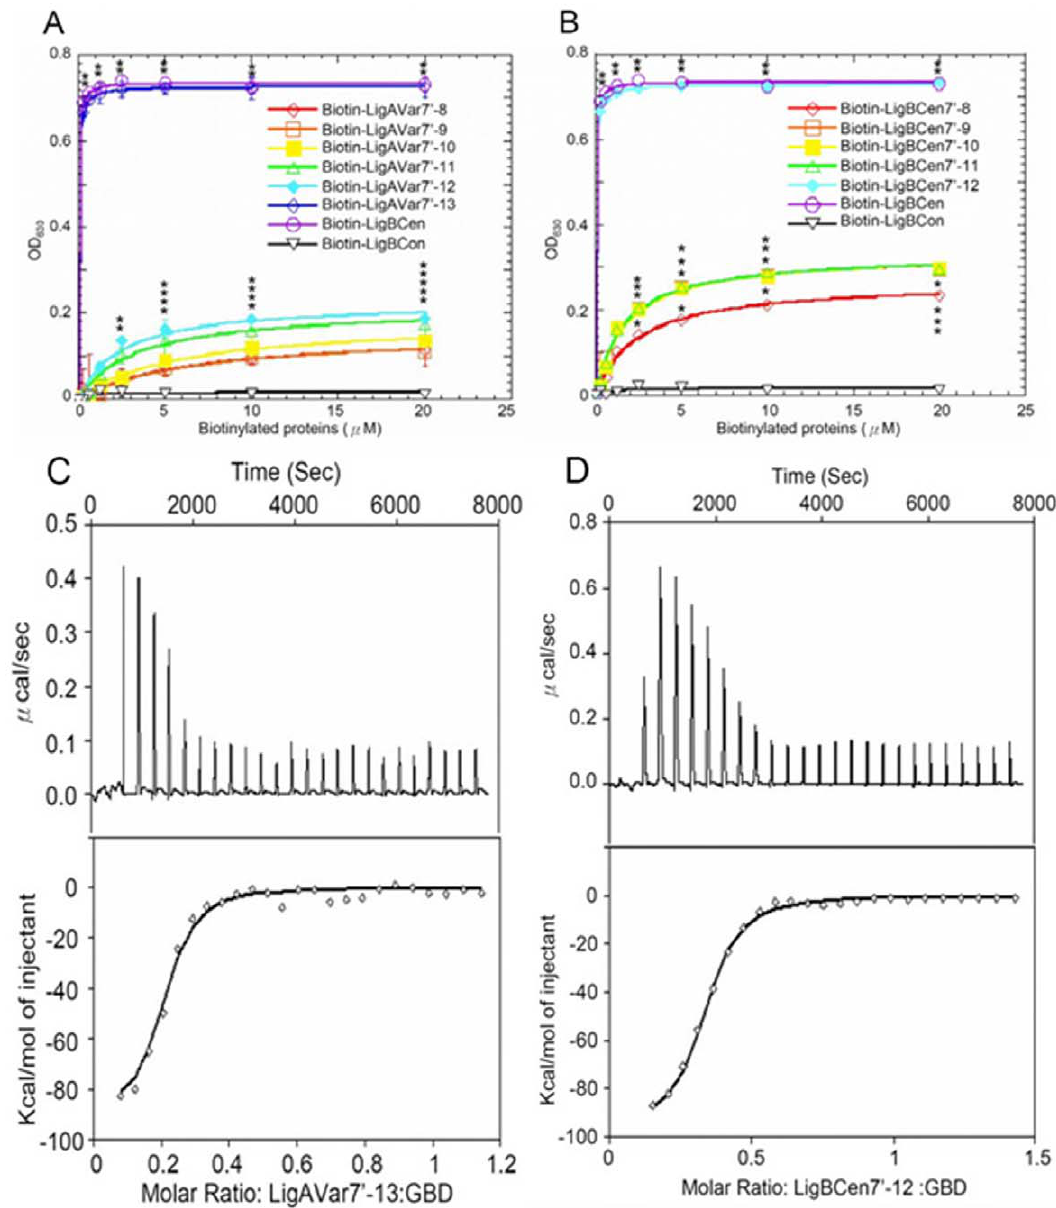
Figure 3. Terminal Ig-like domains mainly contributes to Lig proteins binding to GBD of Fn. (A and B) The binding of GBD to various length Lig proteins constructs performed by ELISA. Various concentrations (0, 0.3125, 0.625, 1.25, 2.5, 5, 10, 20 m M) of biotinylated LigCon (negative control), LigBCen (positive control), and (A) LigAVar7’-8, LigAVar7’-9, LigAVar7’-10, LigAVar7’-11, LigAVar7’-12, or LigAVar7’-13, (B) LigBCen7’-8, LigBCen7’-9, LigBCen7’-10, LigBCen7’-11, or LigBCen7’-12 were added to wells coated with 1 m M of GBD or BSA (negative control and data not shown) in Tris buffer. The binding of biotinylated proteins to GBD was measured by ELISA. For all experiments, each value represents the mean 6 SEM of three trials in triplicate samples. Statistically significant (p , 0.05) differences compared to the negative control are indicated by an asterisk. The KD were obtained from the average of triplicate experiments shown in Table 2. (C and D) Representative ITC isotherms showing the binding of GBD to various length LigA or LigB constructs. The cell contained 1 ml of GBD and the syringe contained 250 m l of (A) LigAVar7’-13, and (B) LigBCen7’-12, (upper panel). Heat differences obtained from 25 injections of LigAVar7’-13 or LigBCen7’-12 (lower panel); Integrated curve with experimental data ( e ) and the best fit (-). The thermodynamic parameters are shown as the average of duplicate experiments in Table 3.